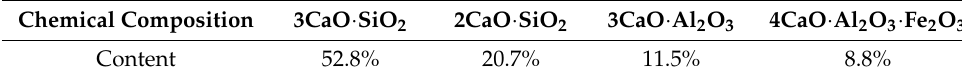
Table 1. Chemical composition of portland cement. Chemical